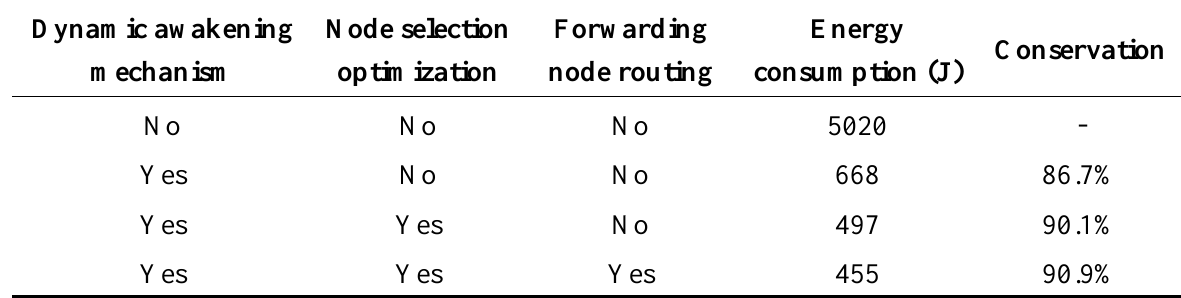
Table 2. Energy consumption and conservation of dynamic energy management